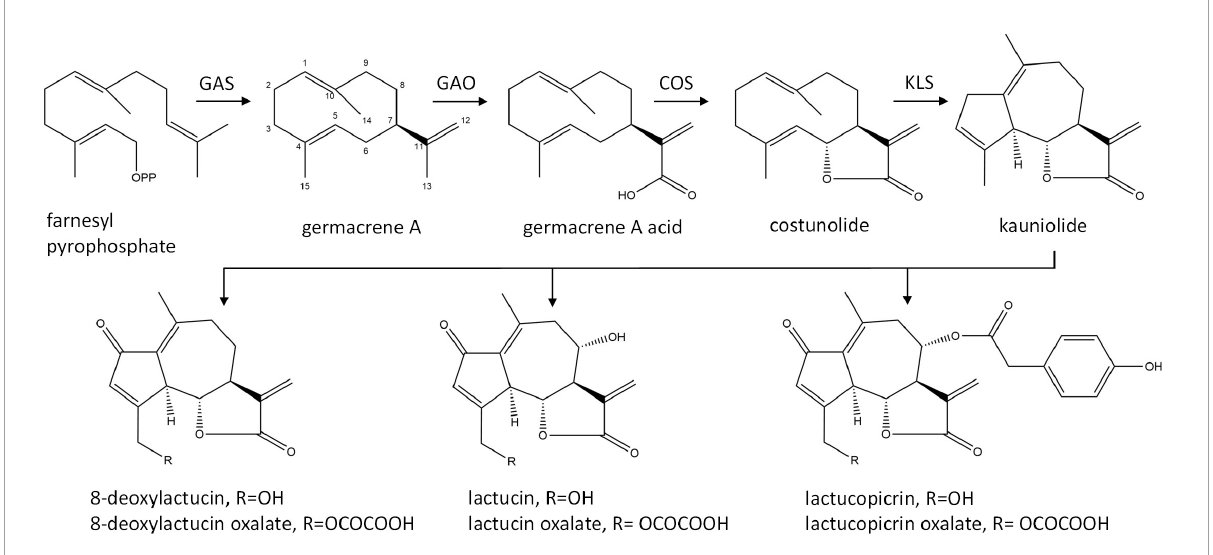
FIGURE1 Biosynthetic pathway of chicory sesquiterpene lactones. GAS, germacrene A synthase; GAO, germacrene A oxidase; COS, costunolide synthase; KLS, kauniolide